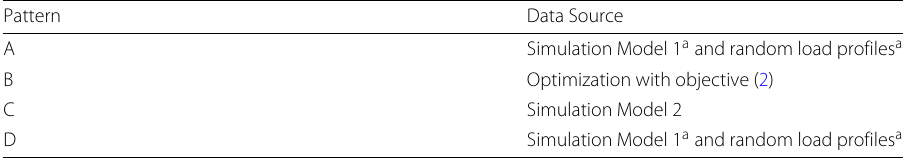
Table 1 Summary of the data given to and generated by the ANNs Pattern